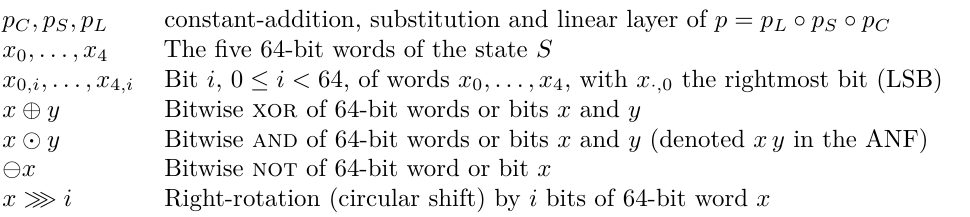
Table 6 lists the notation and symbols used in the following description. Table 6: Notation used for Ascon ’s permutation.